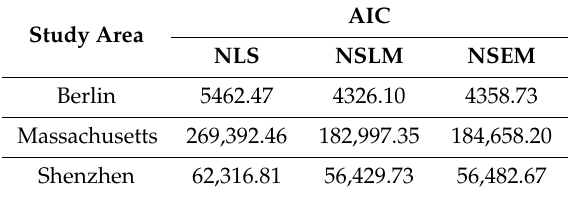
Table2. Akaikeinformationcriterion(AIC)valuesofthethreeregressionmodelsinthethreestudyareas. Study